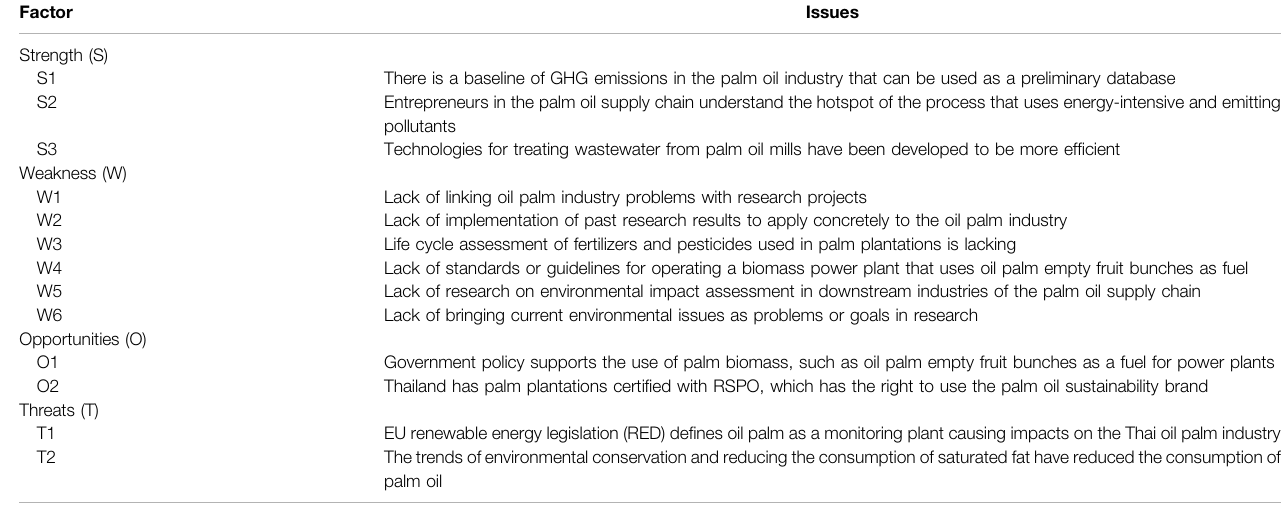
TABLE 3 | SWOT analysis of the environmental impact assessment of the palm oil industry.